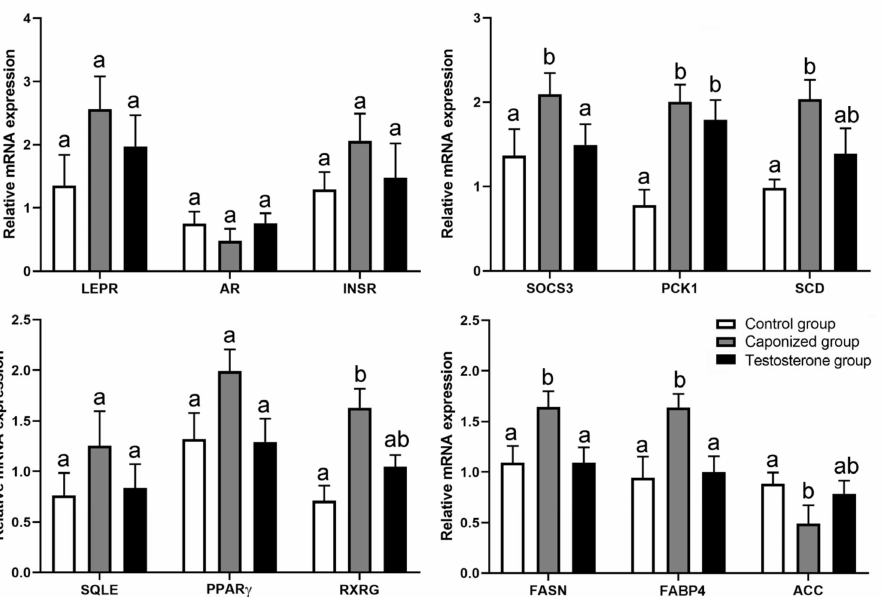
Figure 5. Genes’ mRNA levels relative to β -actin , LEPR , AR , INSR , SOCS3 , PCK1 , SCD , SQLE , PPAR γ , RXRG , FASN , FABP4 , and ACC of abdominal adipose tissues in the control, the caponized group, and the testosterone group. Data are shown as mean values ± standard error of the mean. Vertical bars represent the standard errors of the mean. Different letters above the bars denote significant differences ( p <